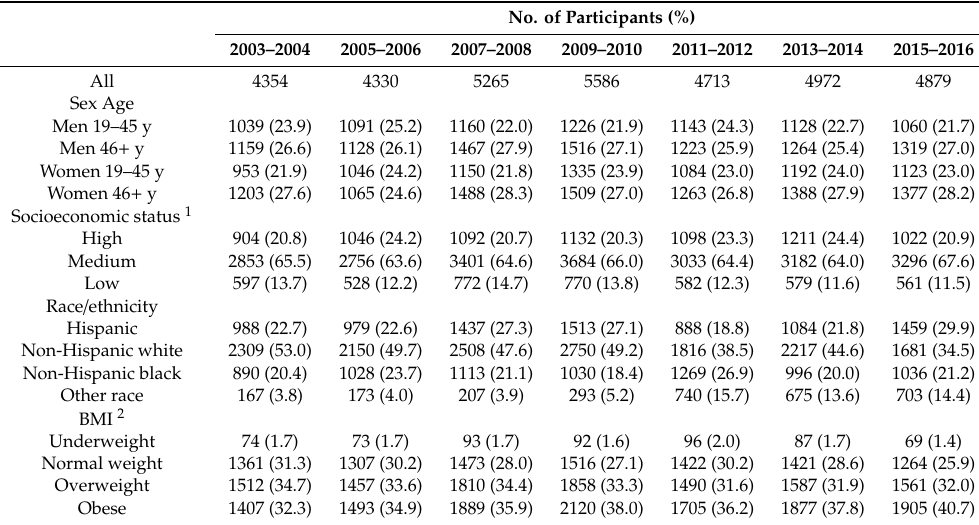
Table 1. Percentages of US adults by population characteristics in the National Health and Nutrition Examination Survey (NHANES